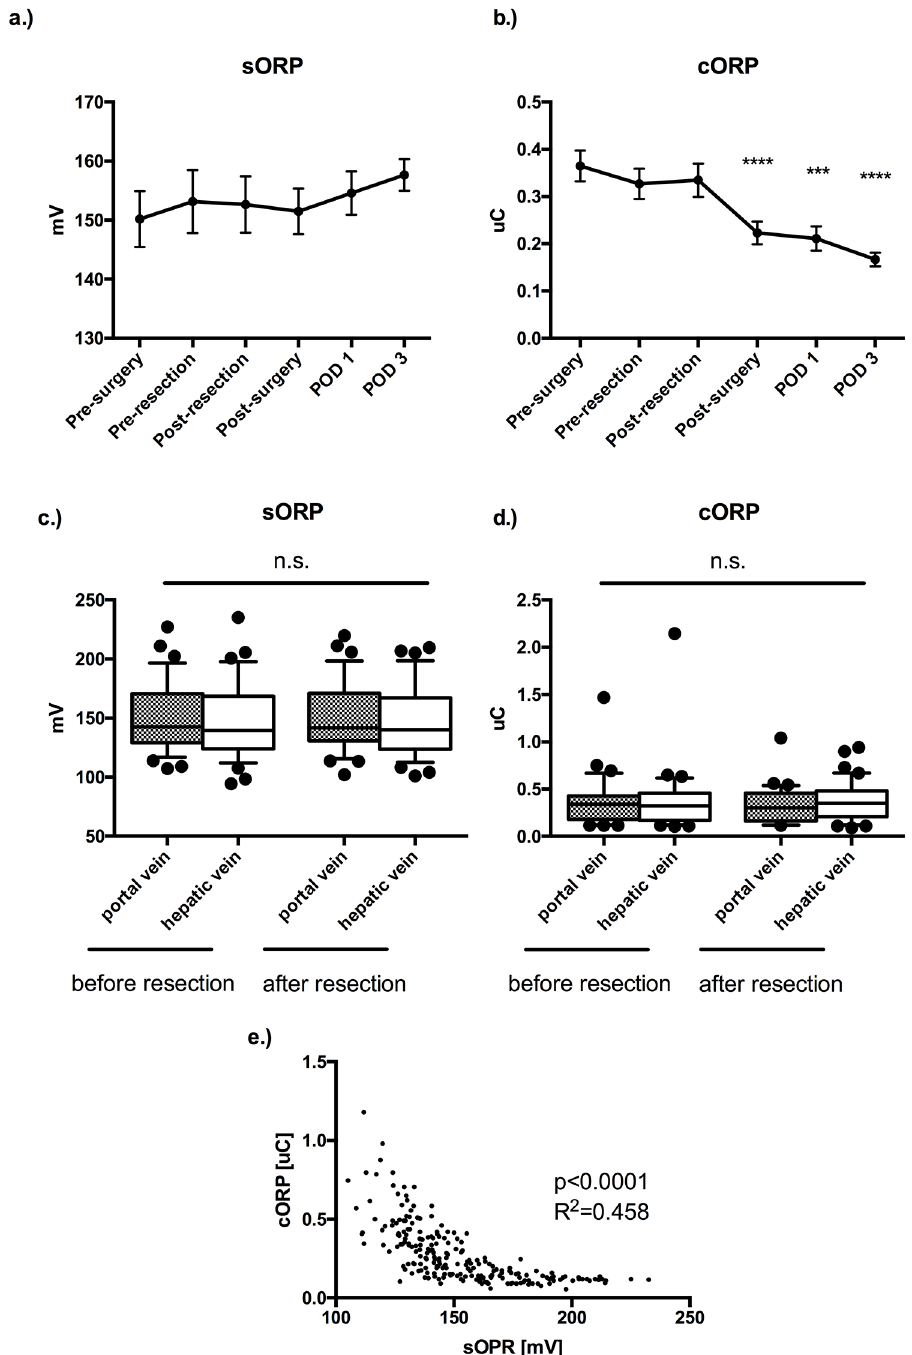
Fig 1. Oxidative stress(OS) during liver resection. (A) OS measuredas static oxidativereduction potential (sORP) remainsrelatively stable duringand after liver resection. (B) However, capacity oxidative reduction potential(cORP) significantly decreasesafter surgery and on postoperative day 1 and 3 (p < 0.001). (C, D) Both, OS and capacity in the in- and outflow of the liver (portal vein, hepaticvein) remainedvirtually unchanged before and after liver resection, respectively. (E) OS is tightly regulated,as there was a significant correlationbetweensORP and cORP measuredsystemically (p < 0.0001; R 2 : 0.458). Data are expressedas means with standard error of the mean (SEM) and comparisonwas performed by using a pairedt-test (A, B) or an unpairedt-test (C, D). Correlationwas calculatedby using the Pearson-test (D). n.s. non significant, *** p < 0.001, **** p <